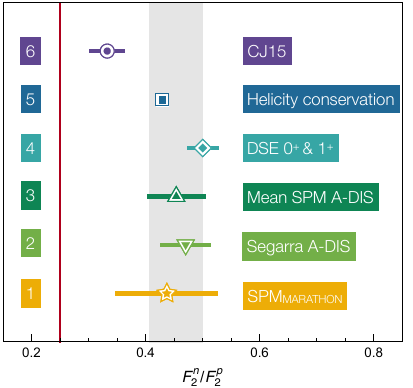
( x ) . SPM prediction derived from Reference[445] (MARATHON) ( x ) / F p Figure 27. lim x → 1 F n 2 2 compared with results inferred from: nuclear DIS [456]; large- x estimate from CSM studies [271,450]; quark counting (helicity conservation) [446]; and a phenomenological fit (CJ15) [434]. The red vertical line indicates the Nachtmann lower limit, Equation (63), which is saturated if valence d quarks play no material role at x = 1; Row 3 is the average in Equation